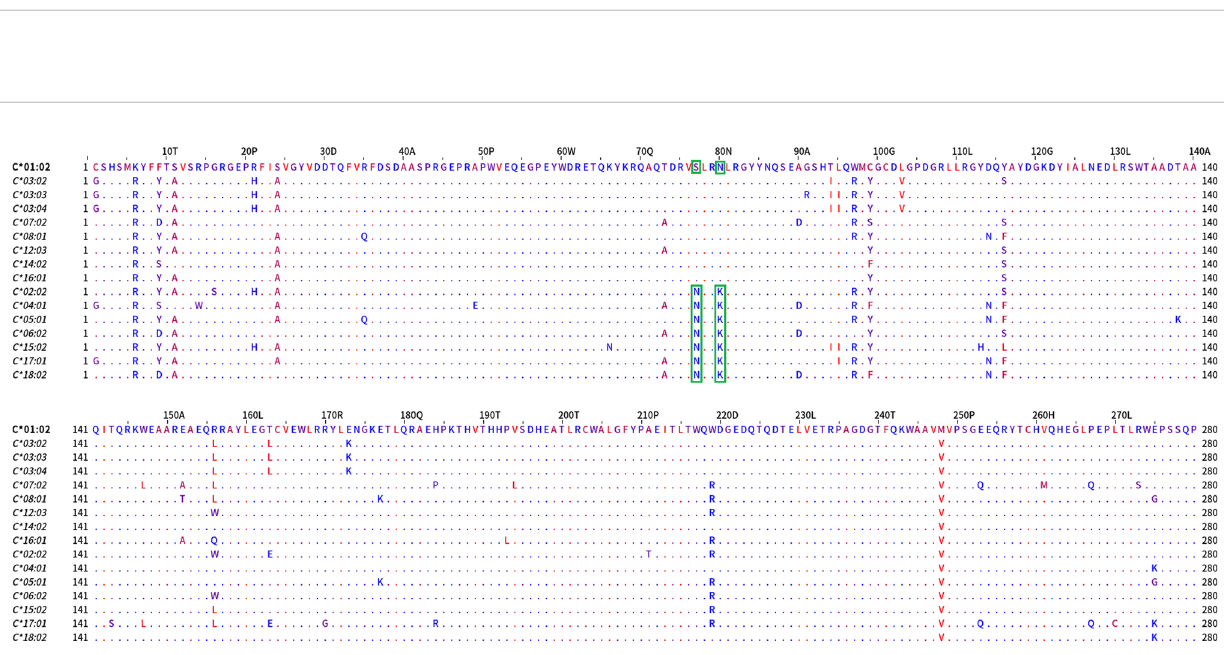
FIGURE 7 | Mature protein sequence alignments of PCA de fi ned groups of HLA-C antigens. Residues are colored according to the hydrophobicity scale of Kyte, J., and Doolittle, R.F. This scale can be used for identifying surface-exposed regions. The most hydrophobic residues are colored red, and the most hydrophilic ones are colored blue. Changes in the patterns of amino acid conservation between group 1 (C*01:02, C*03:02, C*03:03, C*03:04, C*07:02, C*08:01, C*12:03, C*14:02, C*16:01) and group 2 (C*02:02, C*04:01, C*05:01, C*06:02, C*15:02, C*17:01, C*18:02) are enclosed in a green rectangle. Described eplets 76VS, 77S, 80N for group 1 vs eplets 77N and 80K for group 2 are the distinctive factors between the groups that PCA